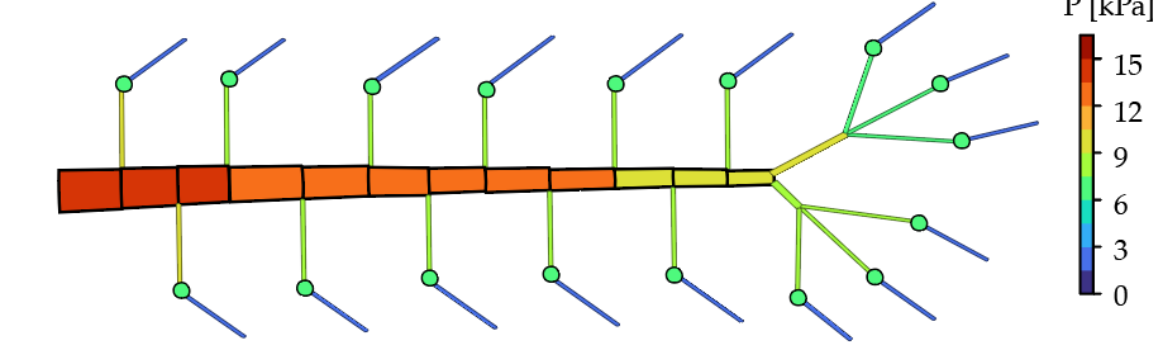
Figure 2. Pressure value distribution of the vascular segment, 𝑃 inlet = 12.7 kPa.